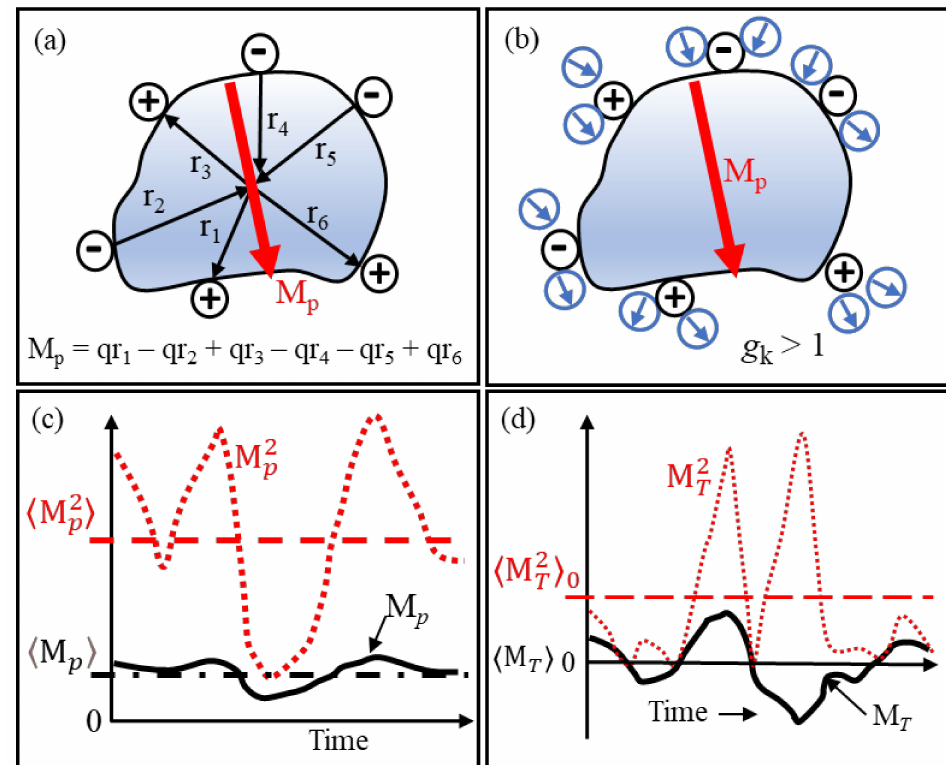
Figure 8. ( a ) Major contributions to the permanent dipole moment M p of a protein are its peptide groups that carry a charge q . ( b ) H 2 0 dipoles near charged groups can act to enhance M p , corre- sponding to a correlation coefficient g k > 1. Reversal of the polarities shown for the water dipoles gives anti-correlation, with g k < 1. ( c ) Brownian ( kT ) changes of location and magnitude of q produce fluctuations with time of M p about its mean value (cid:68) (cid:69) M 2 p square of these fluctuations. ( d ) Without an applied electric field, orientations of the dipoles in a sample of polar fluid are random. The mean value, (cid:104) M T (cid:105) 0 , of the total moment of these dipoles is thus zero. However, due to random fluctuations, its mean square value corresponds to spontaneous